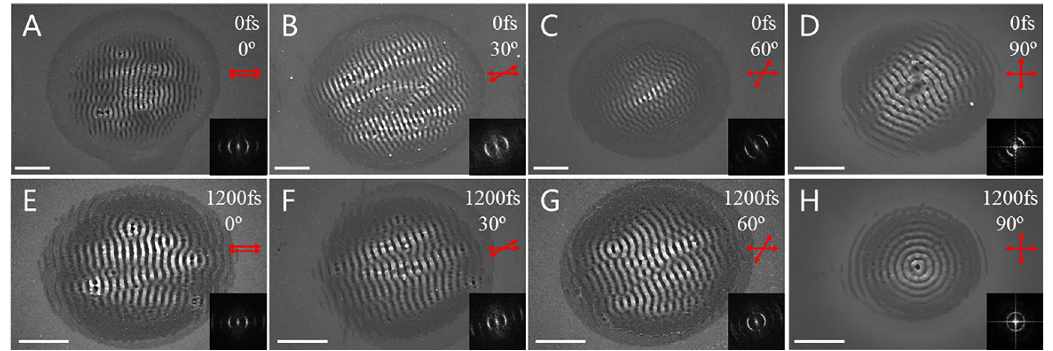
Figure 2: Formation of low-spatial-frequency LIPSS (LSFL) on silicon surfaces through single-spot irradiation with different polarized femtosecond laser double-pulse sequences. The relevant two-dimensional fast Fourier transform (2D-FFT) image is illustrated in the bottom right of each SEM image. The scale bar: represents 5 μ